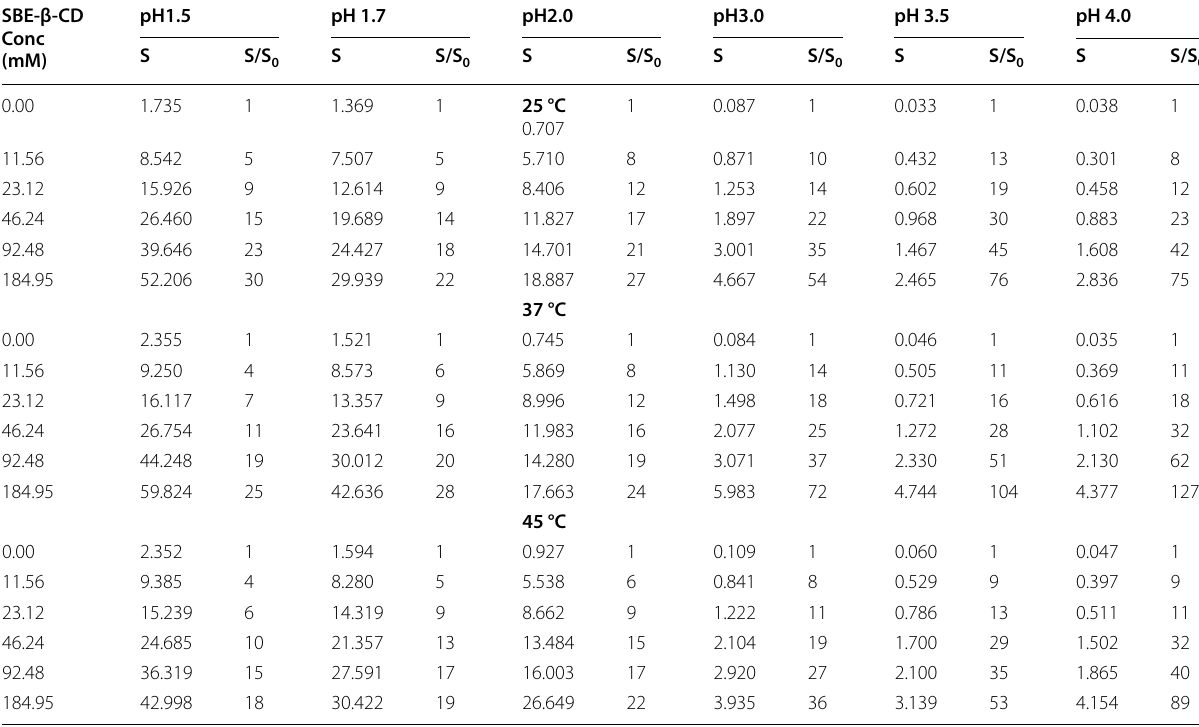
Table 1 Phase solubilization of RDV in SBE‑β‑CD in different pH media SBE‑β‑CD Conc